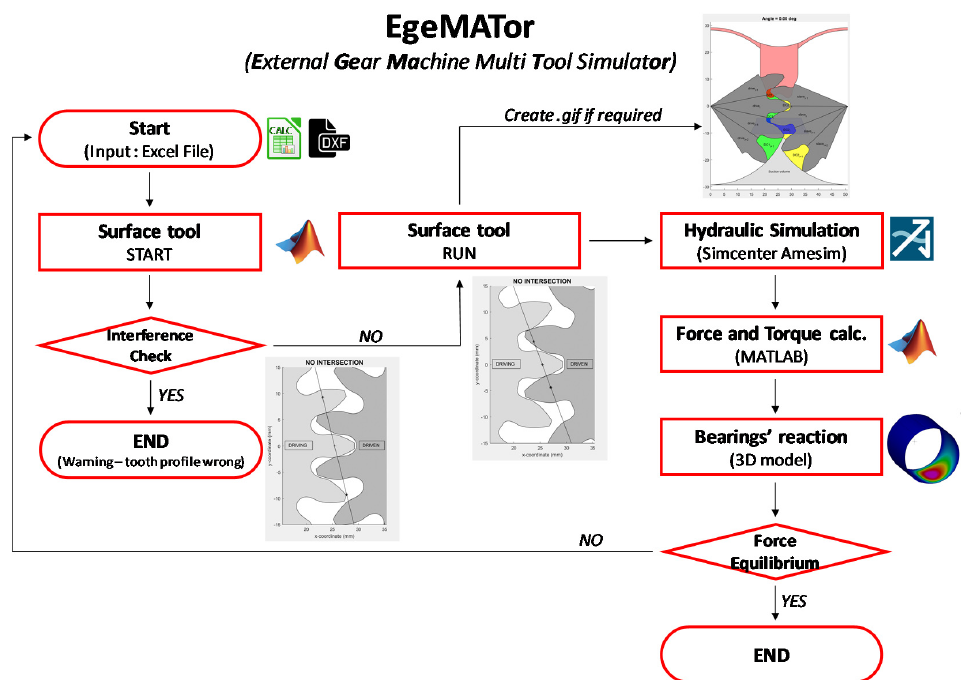
Figure 2. The EgeMATor’s (External Gear Machine Multi Tool Simulator) workflow .